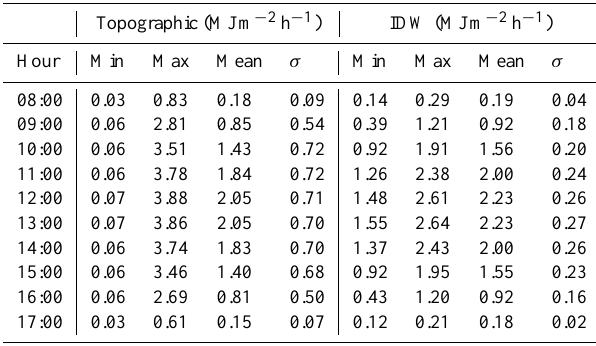
Maximum, minimum, mean and standard deviation (MJm − 2 h − 1 ) of hourly solar radiation estimates in the watershed on the 20 November 2004 obtained by the topographic approxima- tion and IDW to the values measured at stations with hourly avail- able datasets (601, 602, 603 and